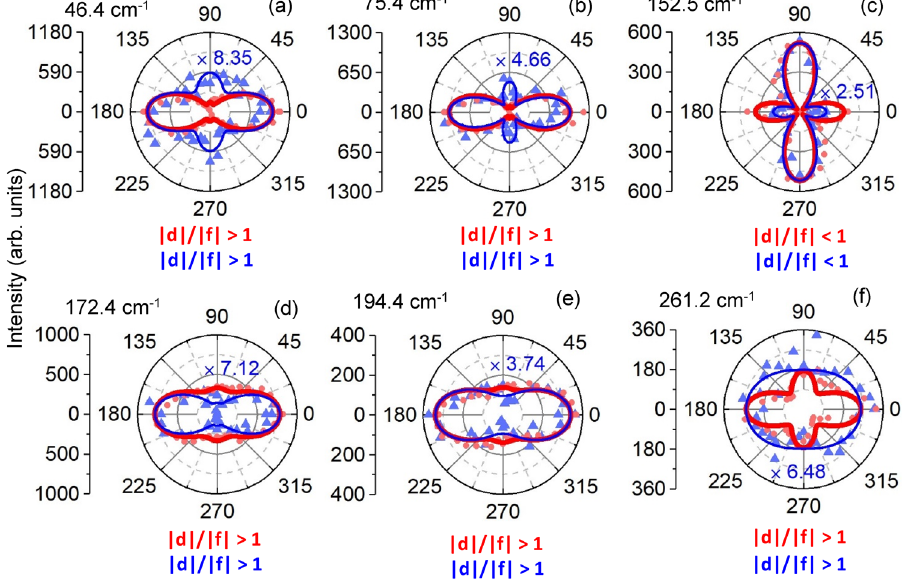
Figure 4. Intensity polar plots ( a – f ) of six observed Raman modes of NbIrTe 4 with a |d|/|f| ratio of larger or smaller than 1 for both excitation wavelengths. In ( c ) the ratio of |d|/|f| is smaller than 1 and all others are larger than 1. Red (blue) curves illustrate theoretical fitting of measurements for 633 nm (514 nm) excitation. To facilitate comparison, a magnification is applied for each Raman mode measured at 514 nm excitation (blue number within plot).